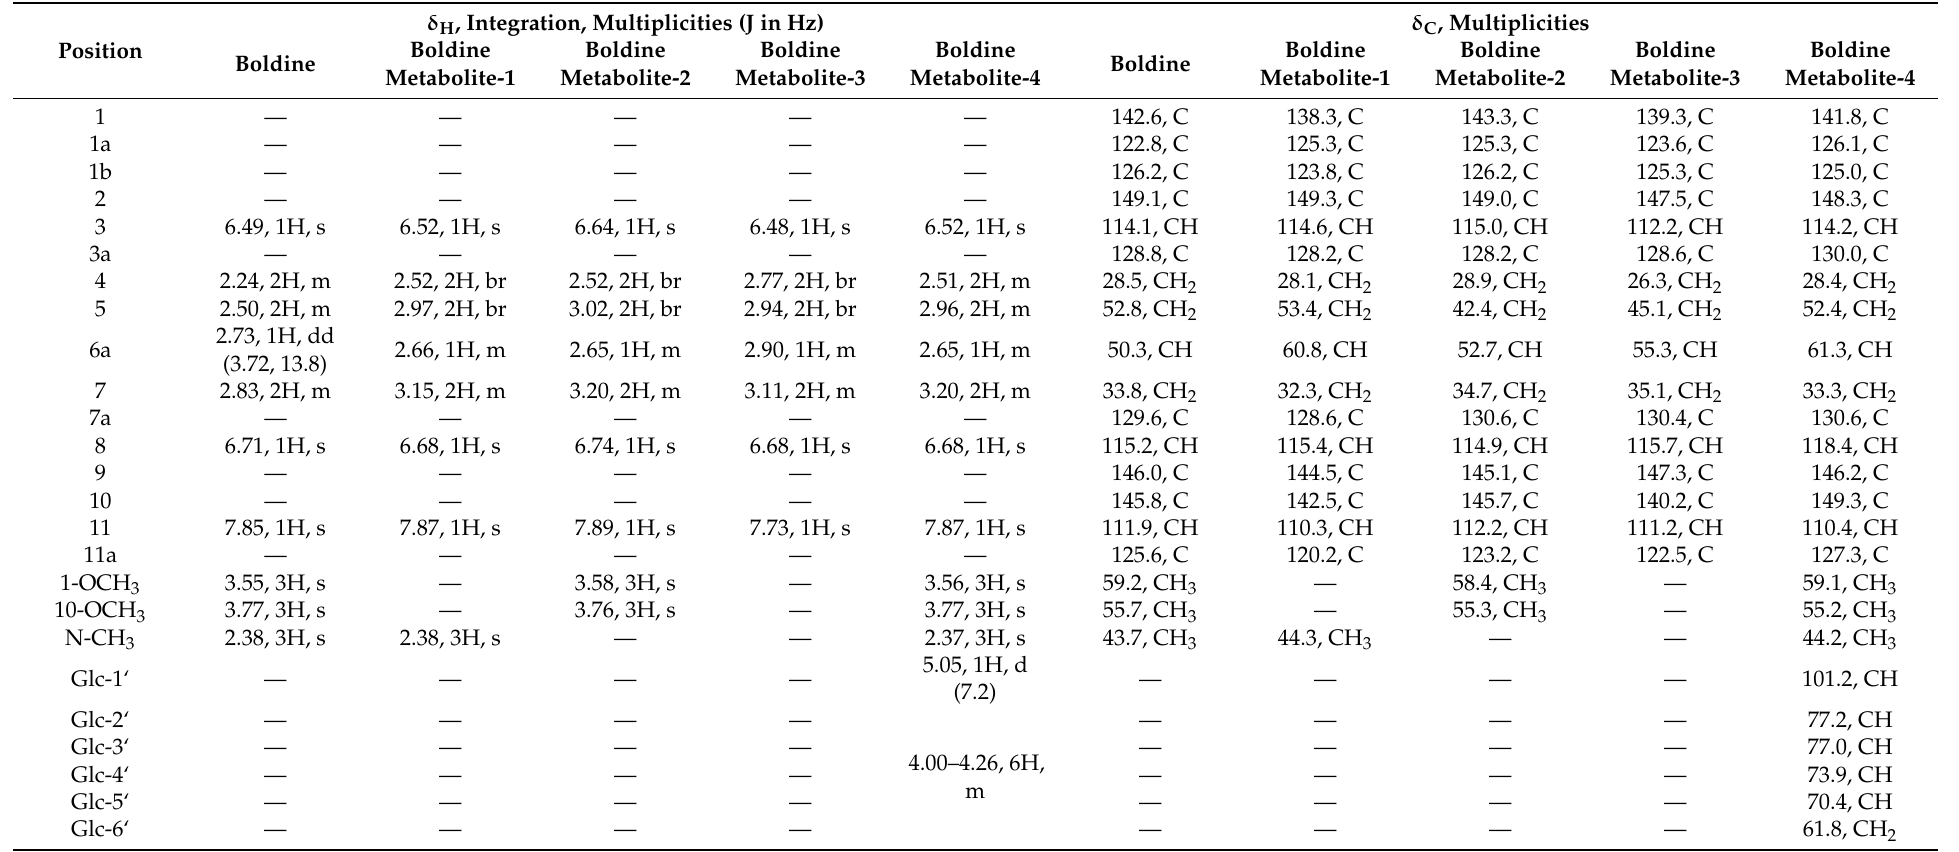
Table 1. Results of 1 H NMR and 13 C NMR analysis of boldine metabolites 1 - 3 and boldine (in CDCl 3 , 400 MHz) and boldine metabolite 4 (in Acetone- d 6